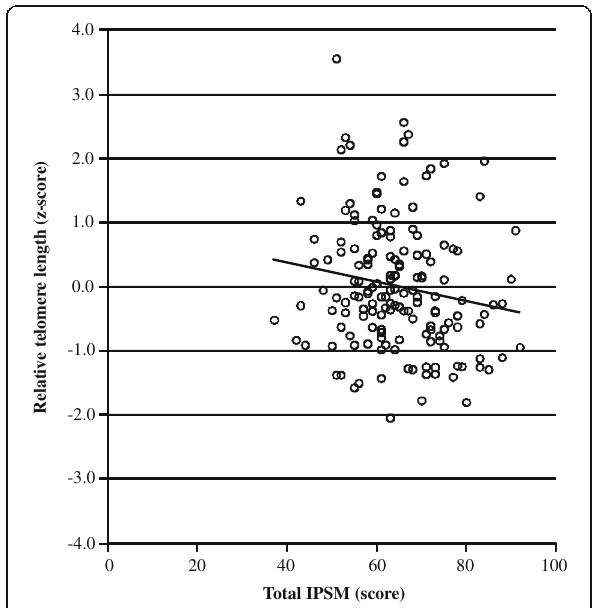
Fig. 1 Relationship between interpersonal sensitivity and telomere length. IPSM; Interpersonal Sensitivity